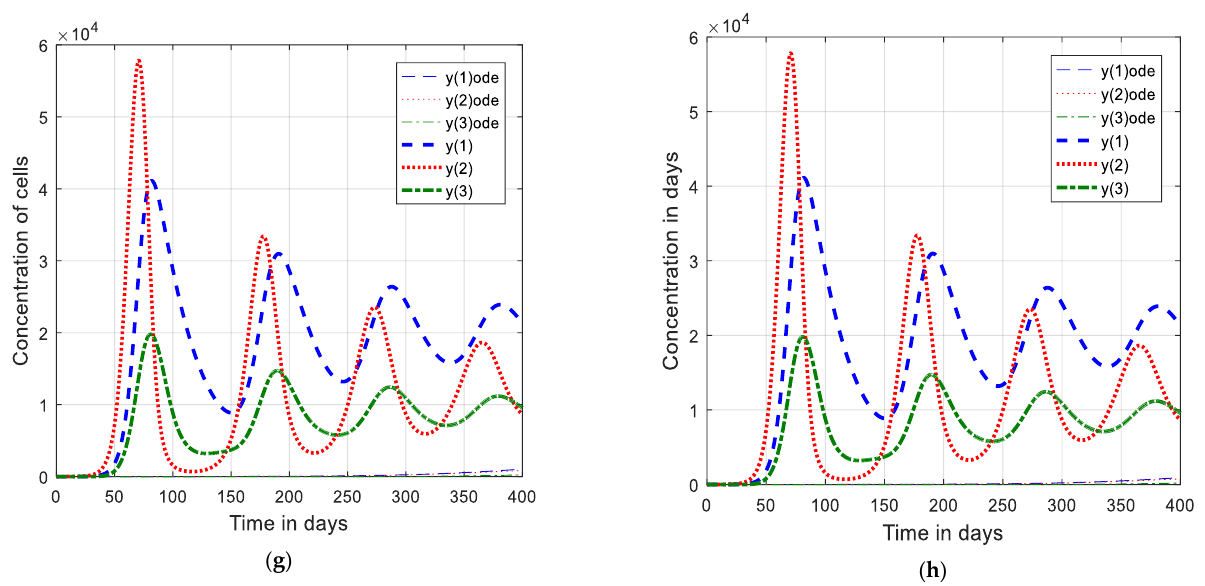
− − − t y effector cells, 1